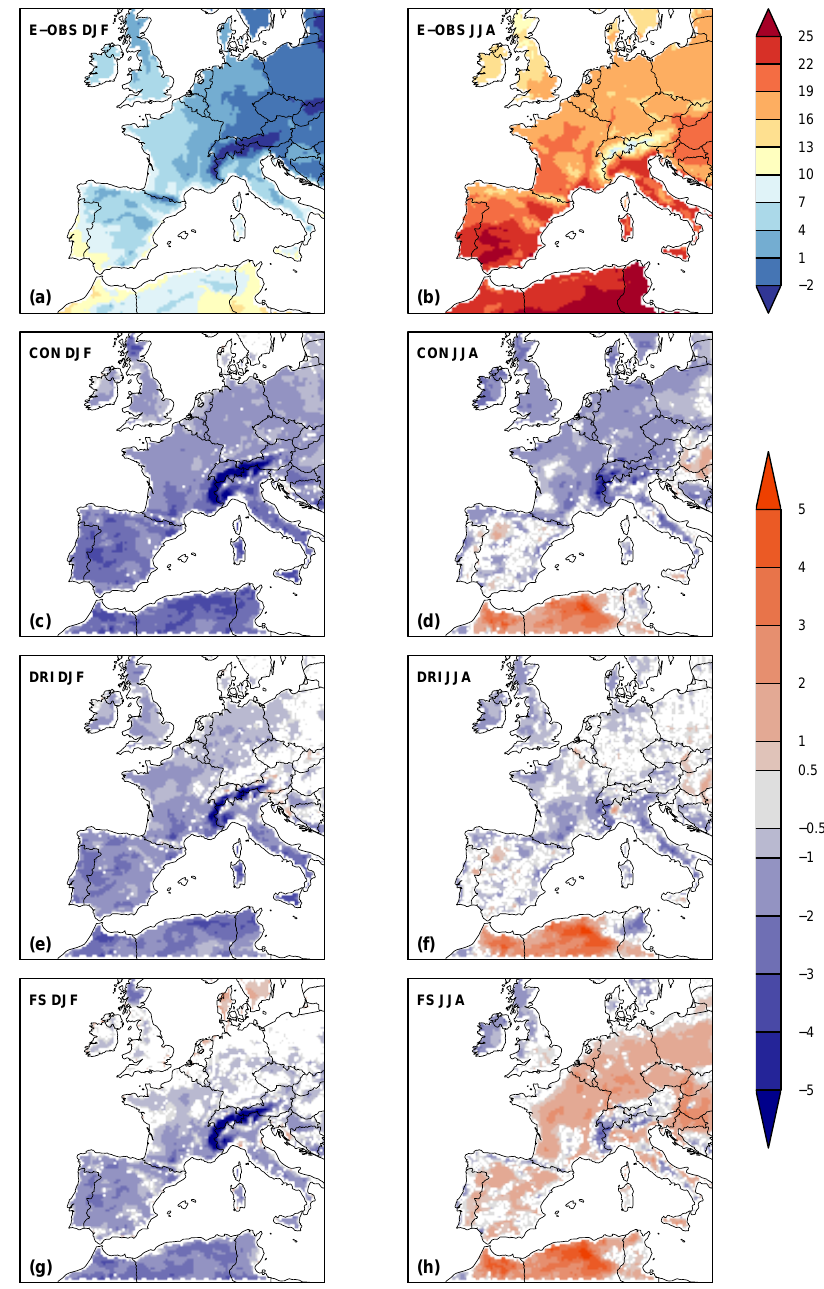
Figure 3. Daily mean 2m temperature ( ◦ C) for E-OBS DJF (a) and JJA (b) , and absolute bias ( ◦ C) of the model with E-OBS for CON DJF (c) and JJA (d) , for DRI DJF (e) and JJA (f) and for FS DJF (g) and JJA (h) , all at a 20km horizontal resolution for the 10-year period from 1991 to 2000. Only the significant biases are shown, using the Student’s t test at a 5% level, and non-significant biases are shown in